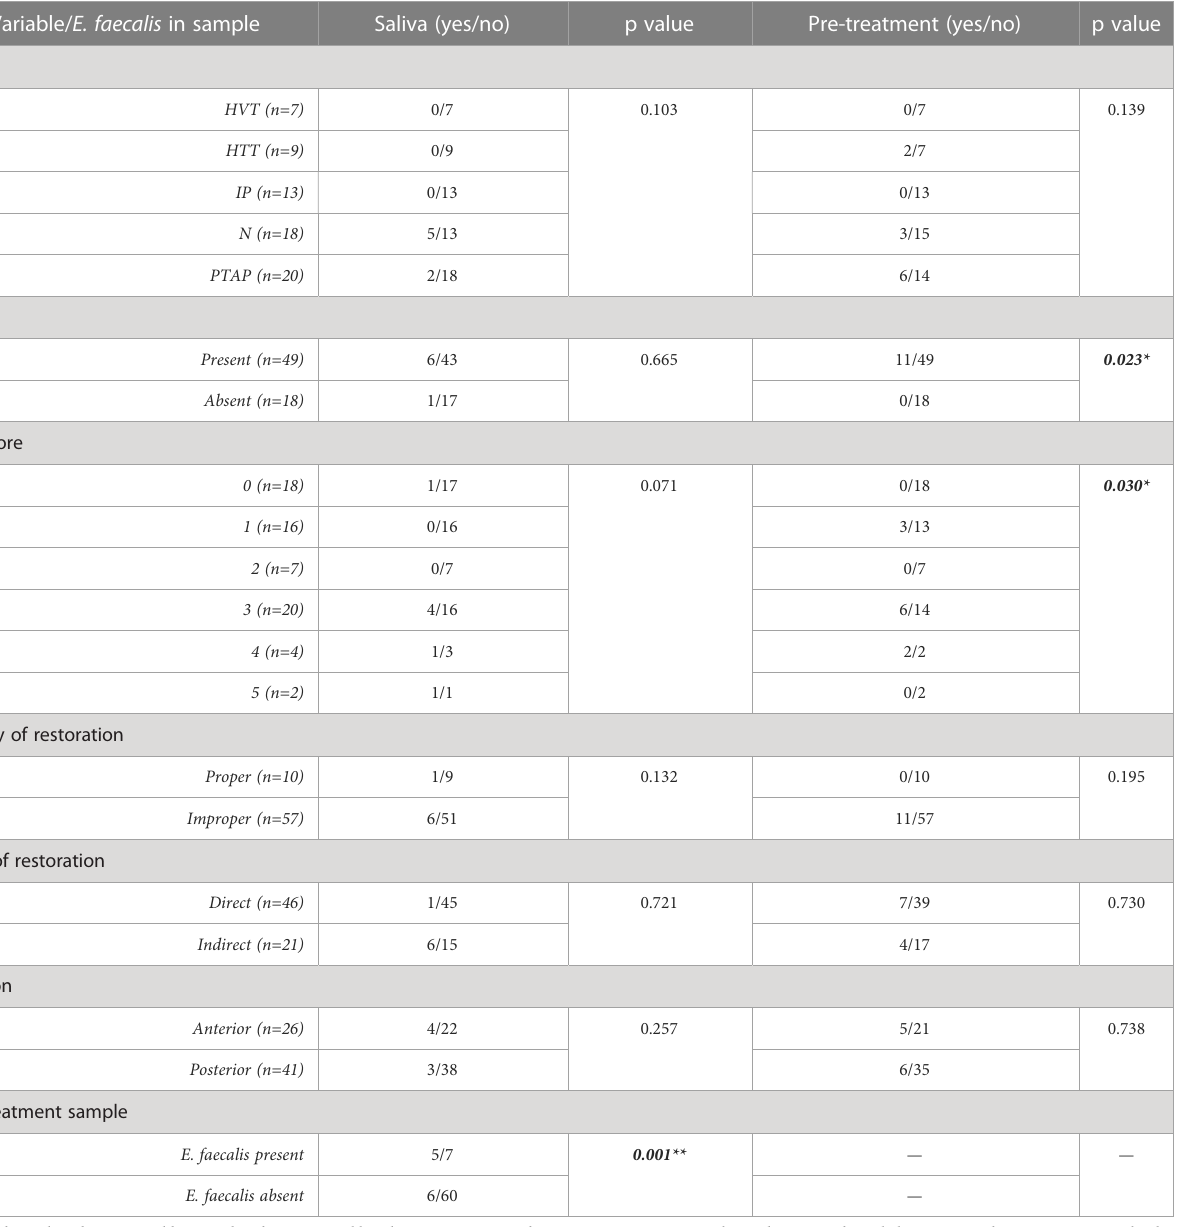
TABLE 2 Inferential statistics and Fisher ’ s test values. Variable/ E. faecalis in